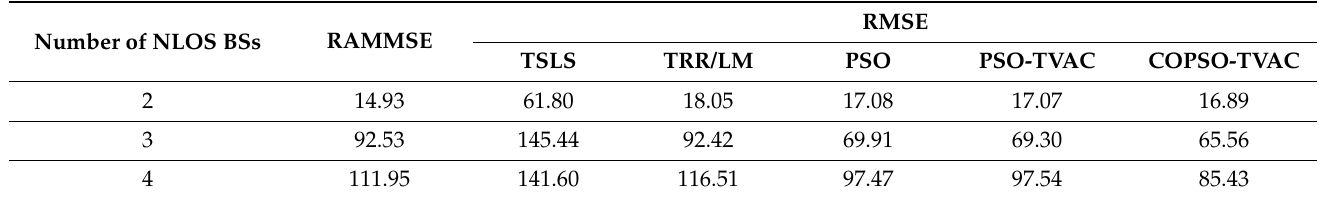
Table 2. Location accuracy for the considered algorithm [m], the suburban environment.